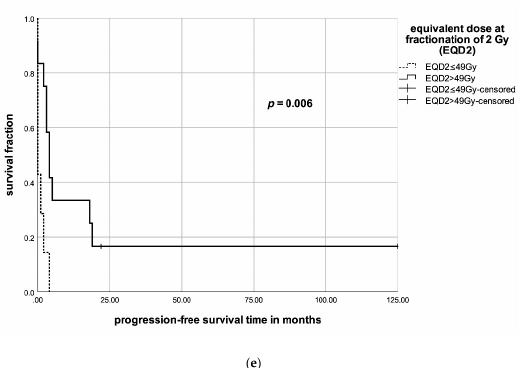
Figure 4. ( a ) Kaplan–Meier diagram for the KPS and progression-free survival (PFS); ( b ) Kaplan–Meier diagram for N status and PFS; ( c ) Kaplan–Meier diagram for the UICC stage and PFS; ( d ) Kaplan–Meier diagram for treatment approaches and PFS; ( e ) Kaplan–Meier diagram for EDQ2 levels and PFS. Table 6. Uni- and multivariate analysis of overall survival (OS). Multivariate